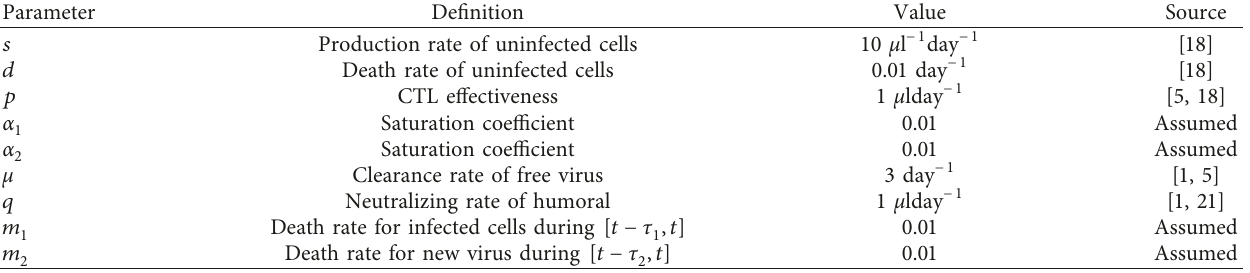
Table 1: List of parameters.